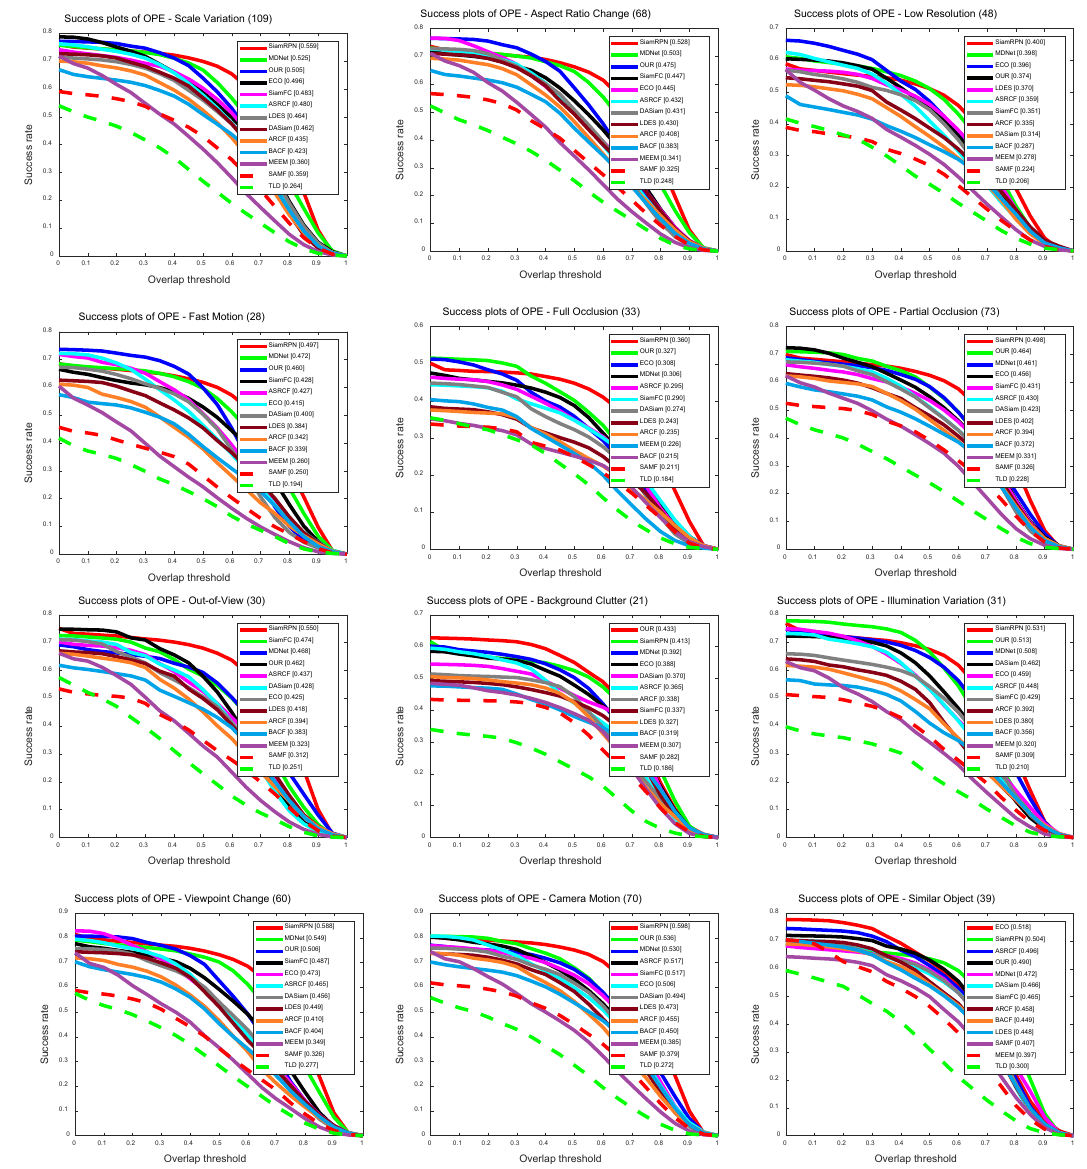
Figure 13. Precision plots based on tracking results on the UAV123 [6] dataset in 12 sequence attributes, including: Scale Variation (SV), Aspect Ratio Change (ARC), Low Resolution (LR), Fast Motion (FM), Full Occlusion (FOC), Partial Occlusion (POC), Out-of-View (OV), Background Clutter (BC), Illumination Variation (IV), Viewpoint Change (VC), Camera Motion (CM), and Similar Object (SOB). The legend of distance precision is threshold scores at 20 pixels. The proposed algorithm performs well against state-of-the-art